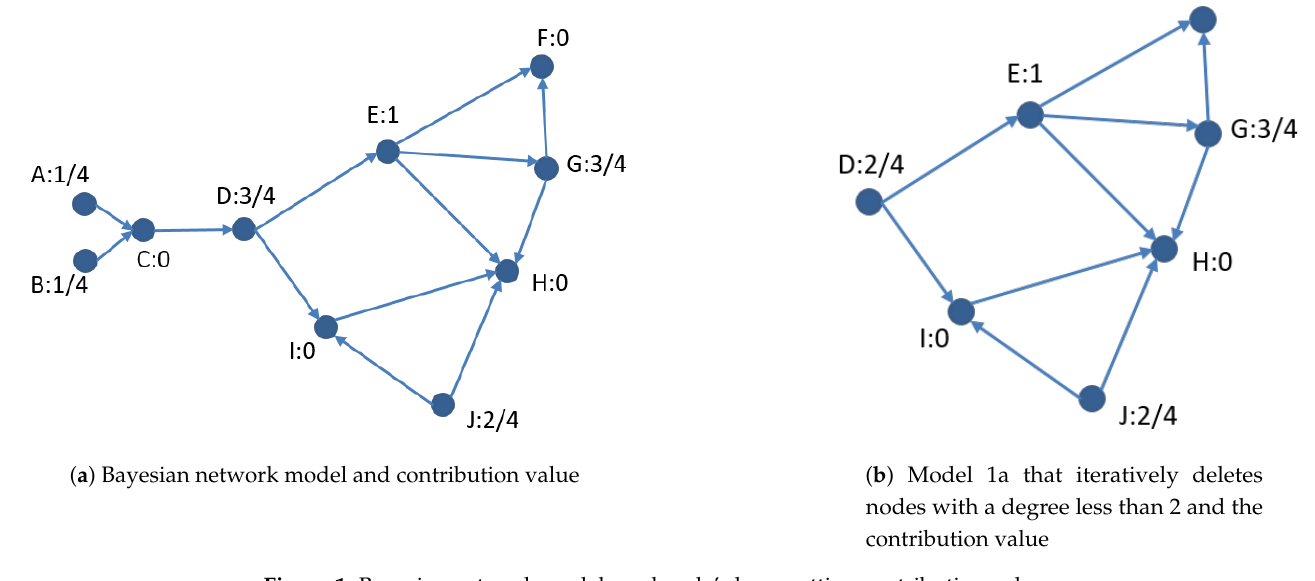
Figure 1. Bayesian network models and node’s loop-cutting contribution